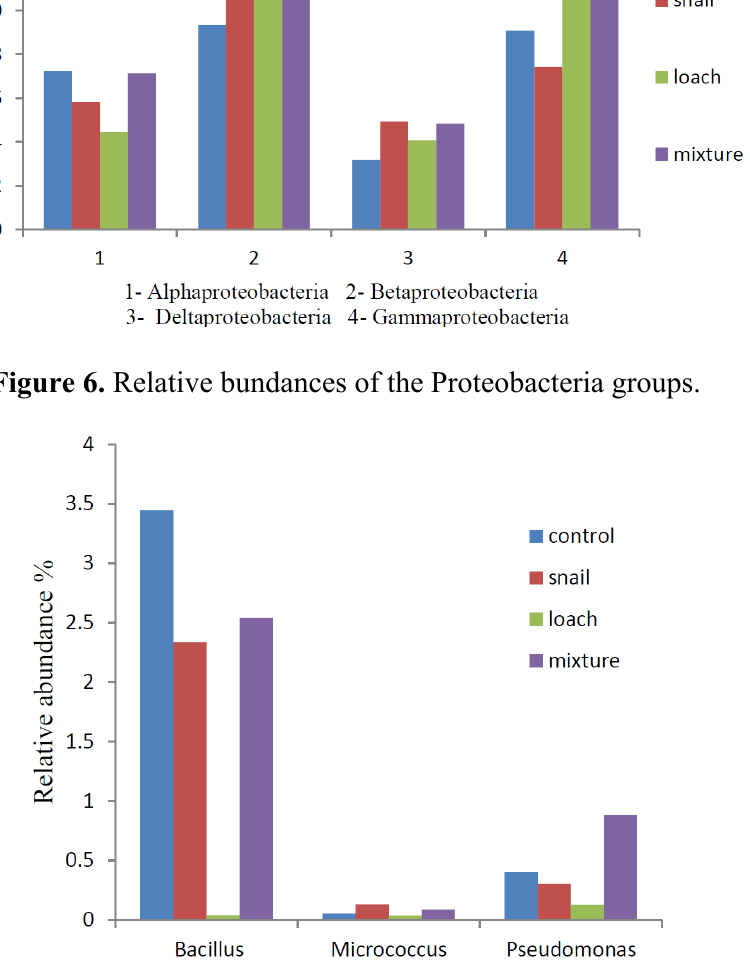
Figure 7. Relative abundances of the denitrifier